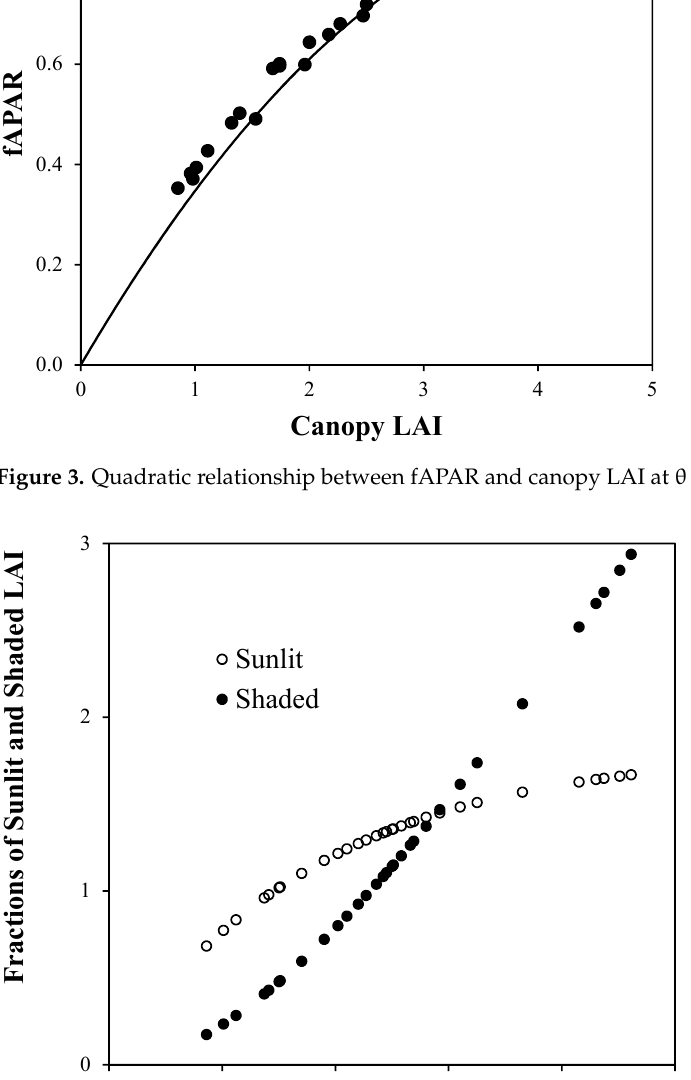
y = −0.04x 2 + 0.39x